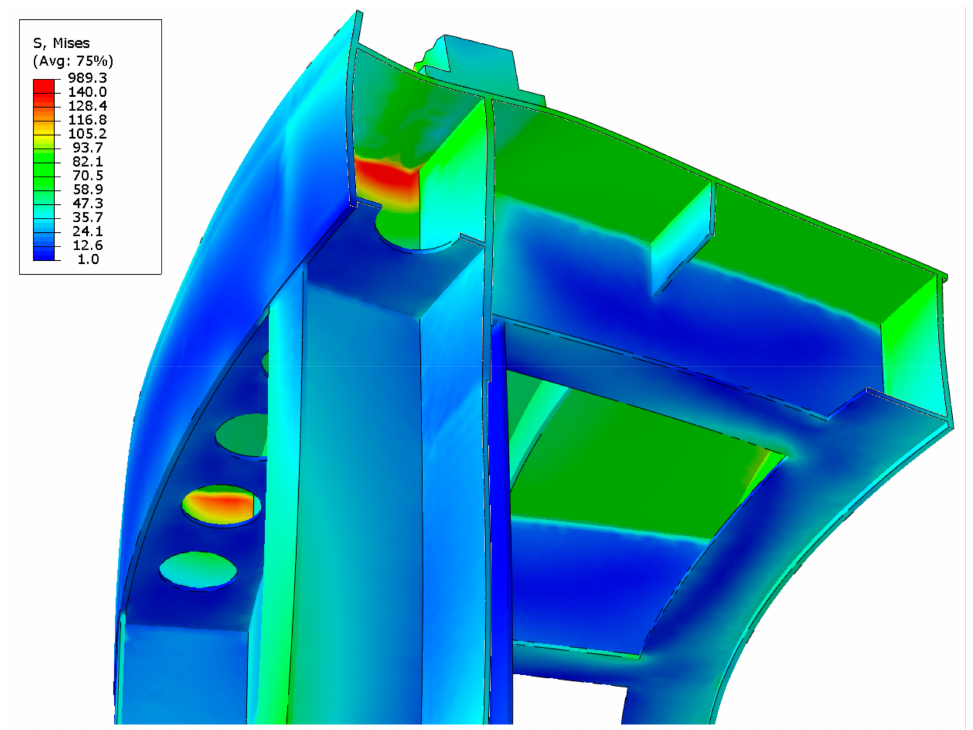
Figure 20. Von Mises stress in MPa in the connection between the upper flange and the web. Deformation at a scale of